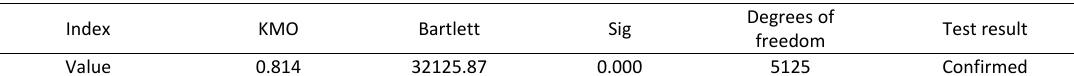
Fig. 1: Research conceptual framework. Table 3: Results of KMO index and Bartlett test calculation Table 3: Results of KMO index and Bartlett